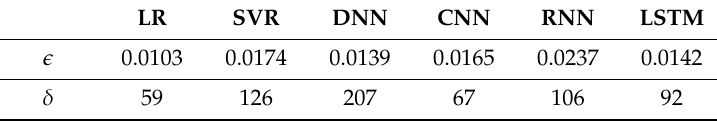
Table 1. Mean values of (cid:15) and δ for training samples of the TFMS dataset.